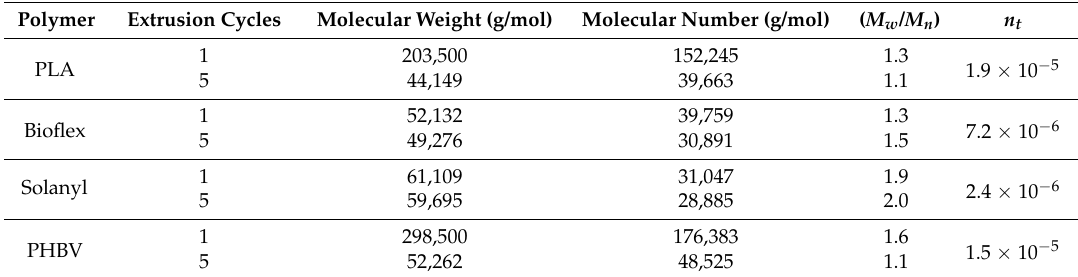
Table 3. The number averaged ( M n ), weight averaged molecular weight ( M w ), disparity, and average number of random chain scissions ( n t ) of